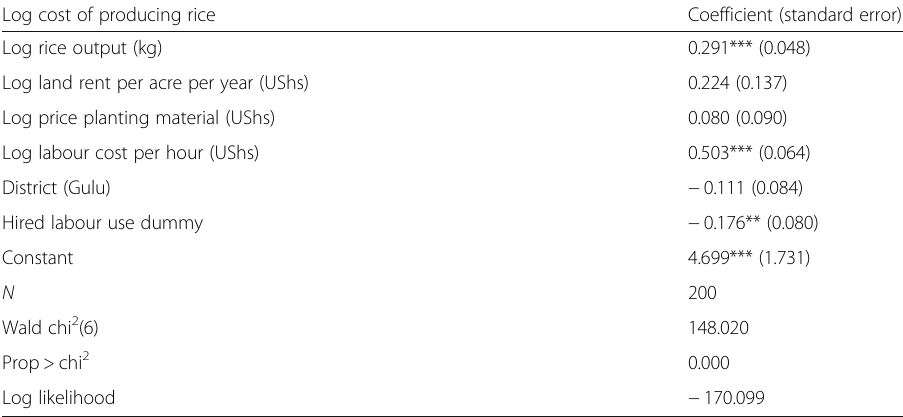
Log cost of producing rice Coefficient (standard error) Log rice output